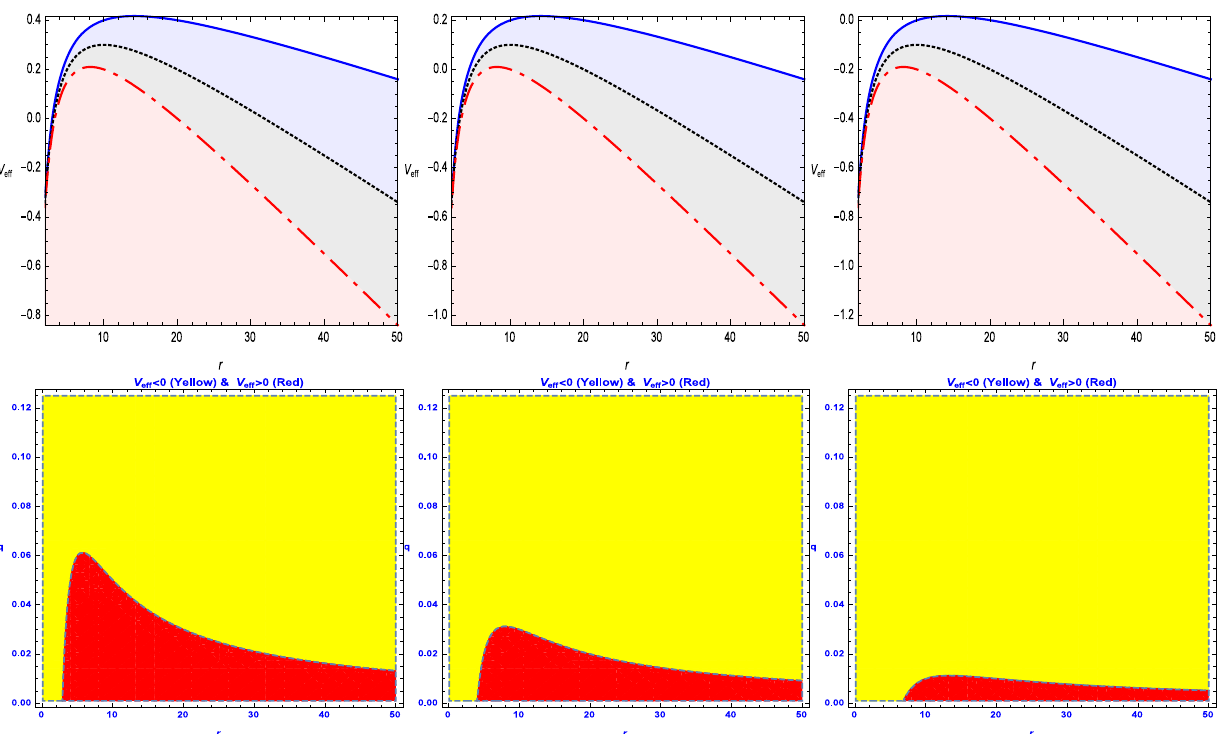
q = 0 . 01 (blue), q = 0 . 02 (black), and q = 0 . 03 (red) with a = 0 . 7. The second row shows the positive and negative region of V ef f ( r ) for three different values of a = 0 . 3 (left panel), a = 0 . 5 (middle panel), and a = 0 . 7 (right